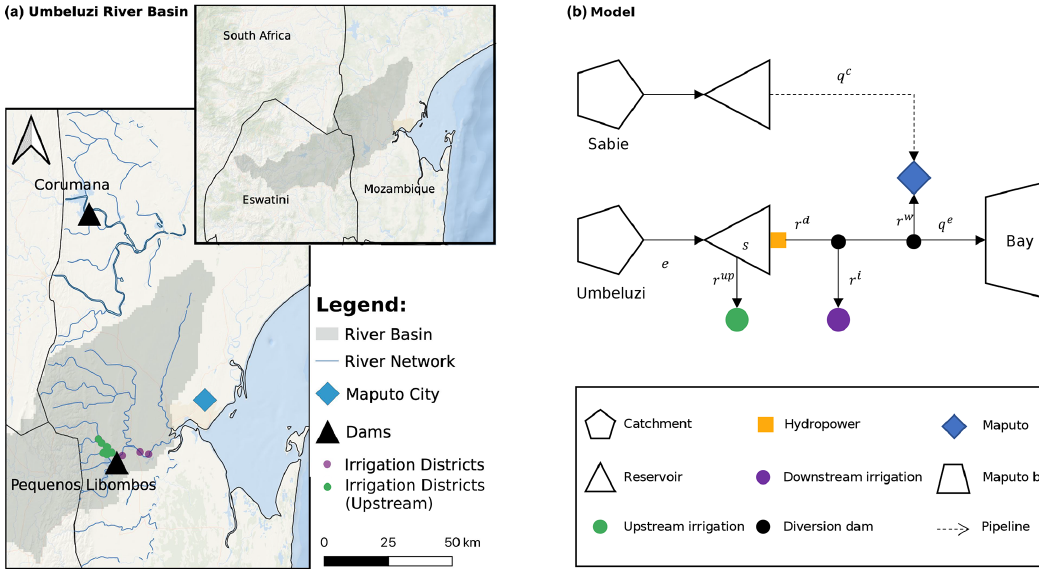
Figure 1. (a) Study Area. (b) Topological map of the system.